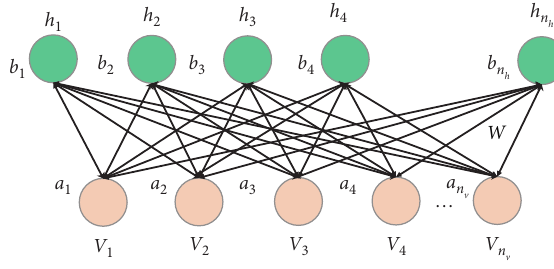
Figure 6: Boltzmann machine learning.